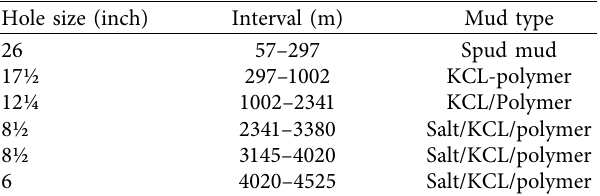
Table 2: Well-A drilling mud